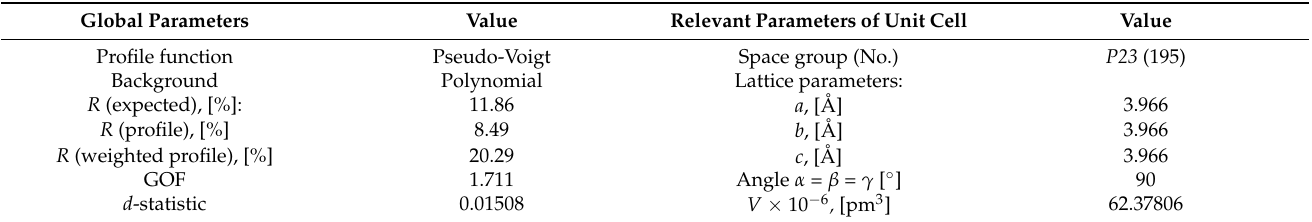
Table 2. Results of the unit cell search calculations for the “downgraded” ( x = 3-4-5) BST thin